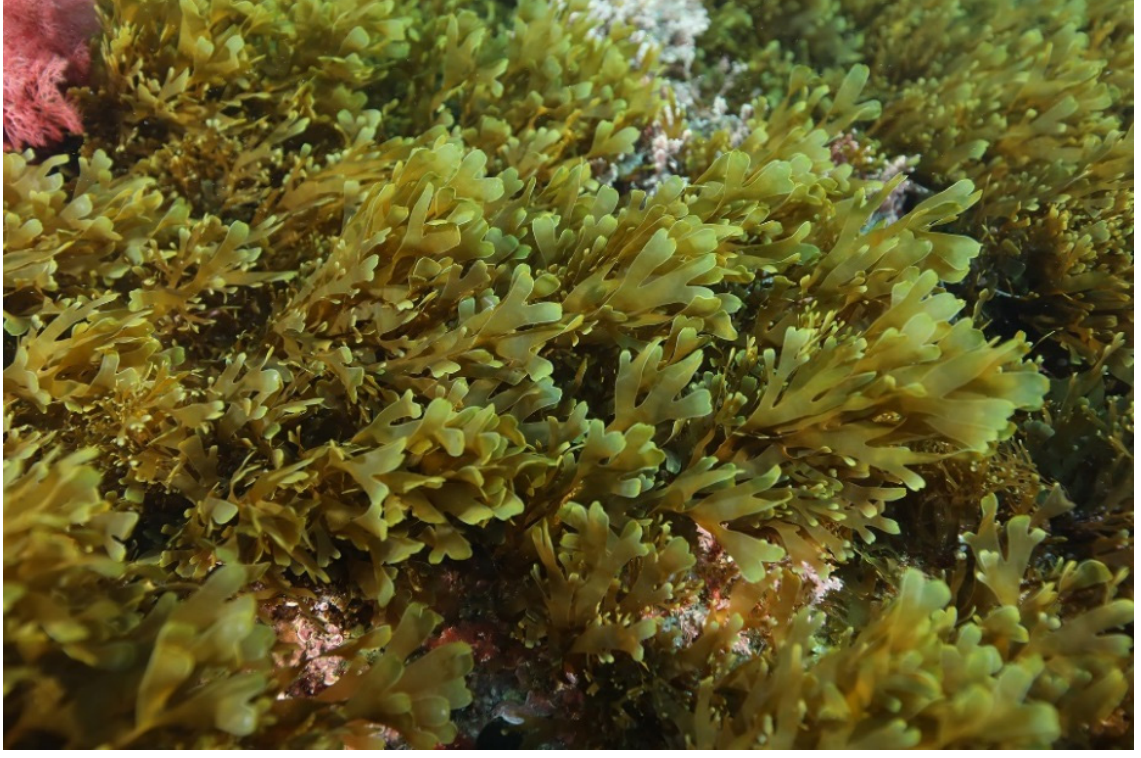
Figure 4. Rugulopteryx okamurae in February 2019. Photo © Sandrine Ruitton.